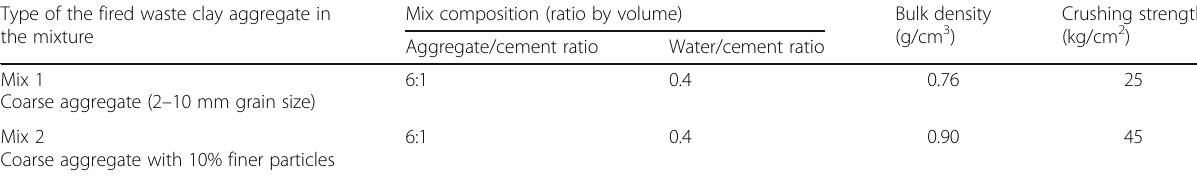
Mix composition (ratio by